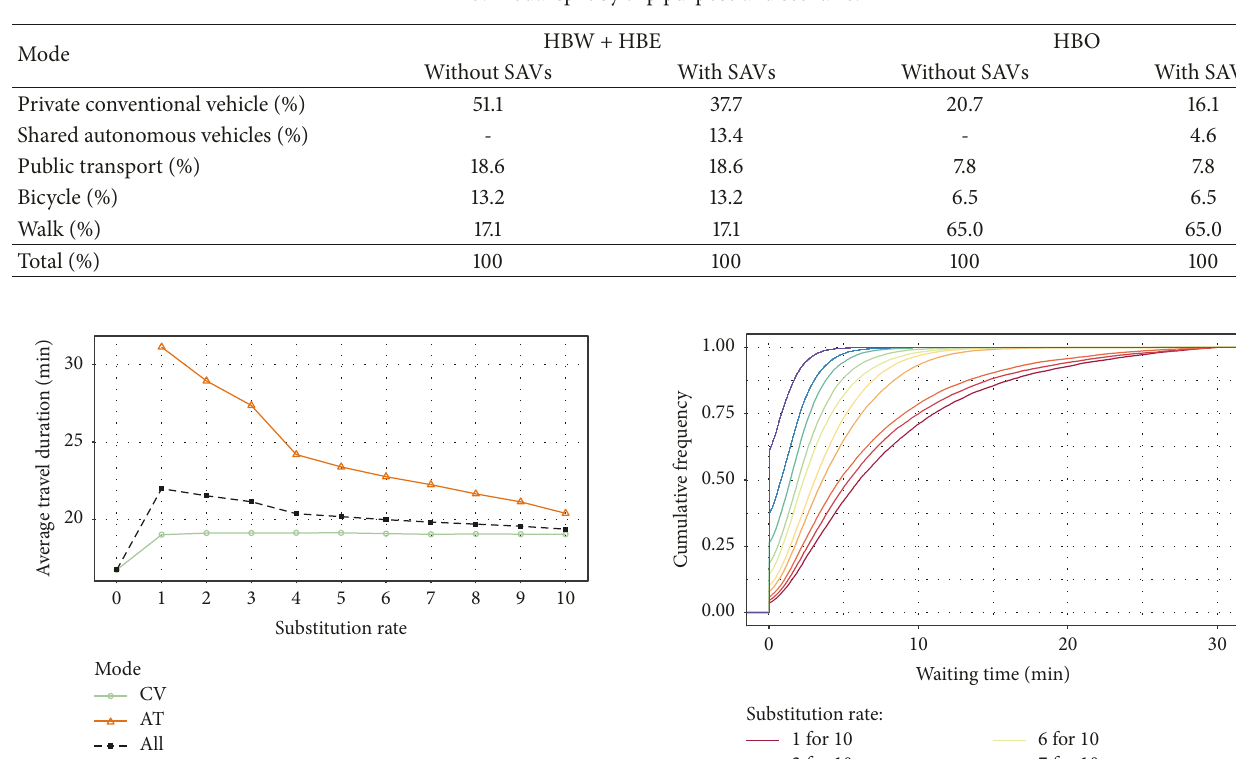
Table 3: Modal split by trip purpose and scenario.